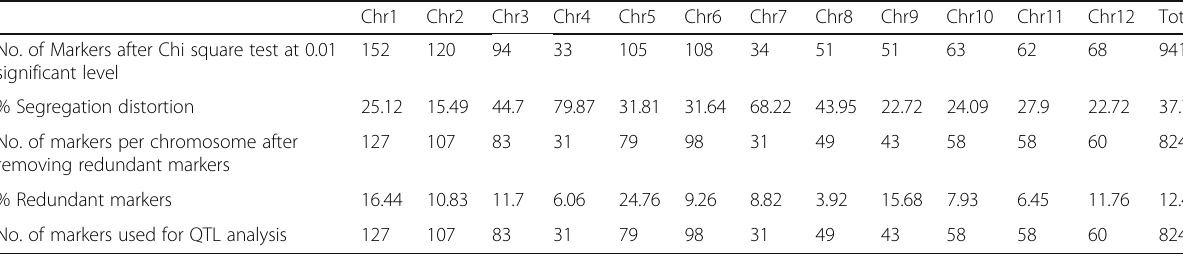
Table 3 Selection of polymorphic markers for QTL mapping Chr1 Chr2 Chr3 Chr4 Chr5 Chr6 Chr7 Chr8 Chr9 Chr10 Chr11 Chr12 Total No. of Markers after Chi square test at 0.01 significant level